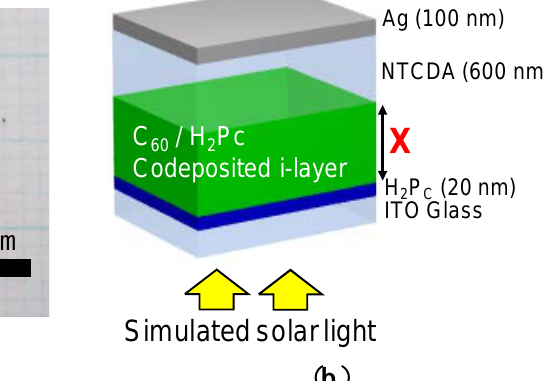
single crystals; ( b ) Structure of organic p-i-n solar cell. Figure 6. ( a ) Photograph of 7N-C 60 The C :H Pc co-deposited layer (thickness: X nm) having a quasi-vertical superlattice 60 2 structure (Figure 5b,d) is sandwiched between p -type H Pc and n -type 2